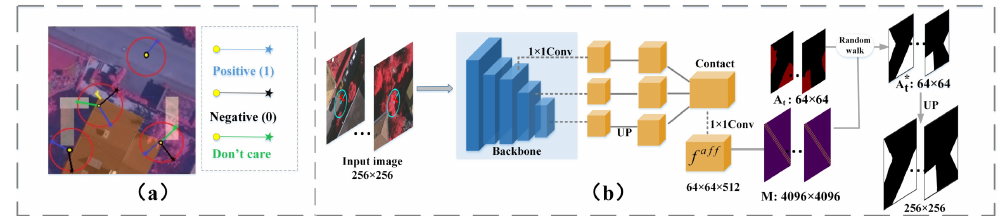
Figure 3. ( a ) Pixel pairs sampled within a radius of r are used to supervise the SAM. The affinity label is set to 1 if the pixel pair is from the same class, otherwise, the label is set to 0. Regions with low confidence (white region) are not involved in supervision. ( b ) Overall architecture of the affinity learning and spreading process in SAM. ’UP’ denotes the upsampling